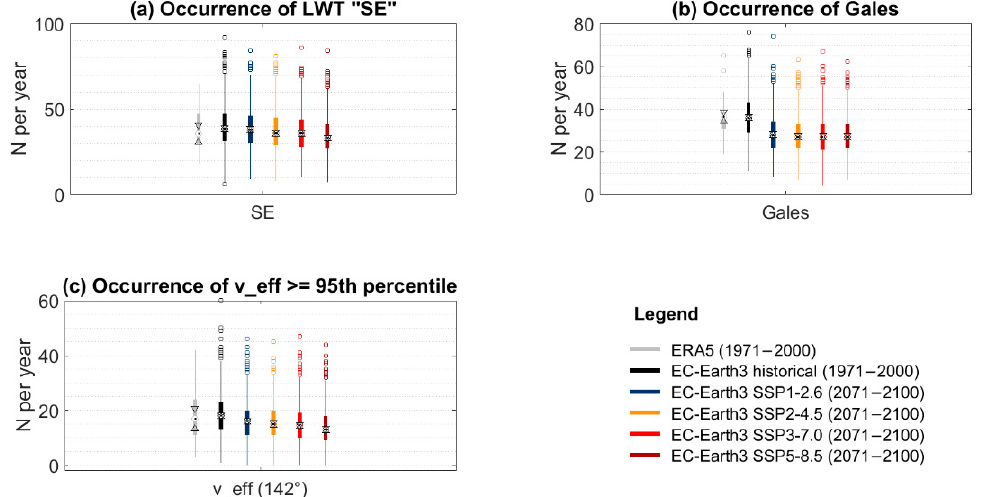
Figure 12. Boxplot of the occurrence of ( a ) the Lamb Weather Type (LWT) “SE”, ( b ) Gales, and ( c ) effective wind speeds ≥ 95th percentile for ERA5 (light grey) and the 50-member SMHI-LENS ensemble (black) for the historical period (1971–2000) and respective runs for each the SSP-Scenarios 1–2.6 (blue), 2–4.5 (orange), 3–7.0 (light red), and 5–8.5 (dark red) for the far future (2071–2100). Boxplots display the median (black dot), the interquartile range (25–27th Percentile, box), the extremes, i.e., approximately ± 2.7 sigma and 99.3 coverage, of the distribution (whiskers), and outliers (circles). Notches, depicted as triangles around the median, correspond to q2 − 1.57 (q3 − q1)/sqrt (n) and q2 + 1.57 (q3 − q1)/sqrt (n), where q2 is the median (50th percentile), q1 and q3 are the 25th and 75th percentiles, respectively, and n is the number of observations.